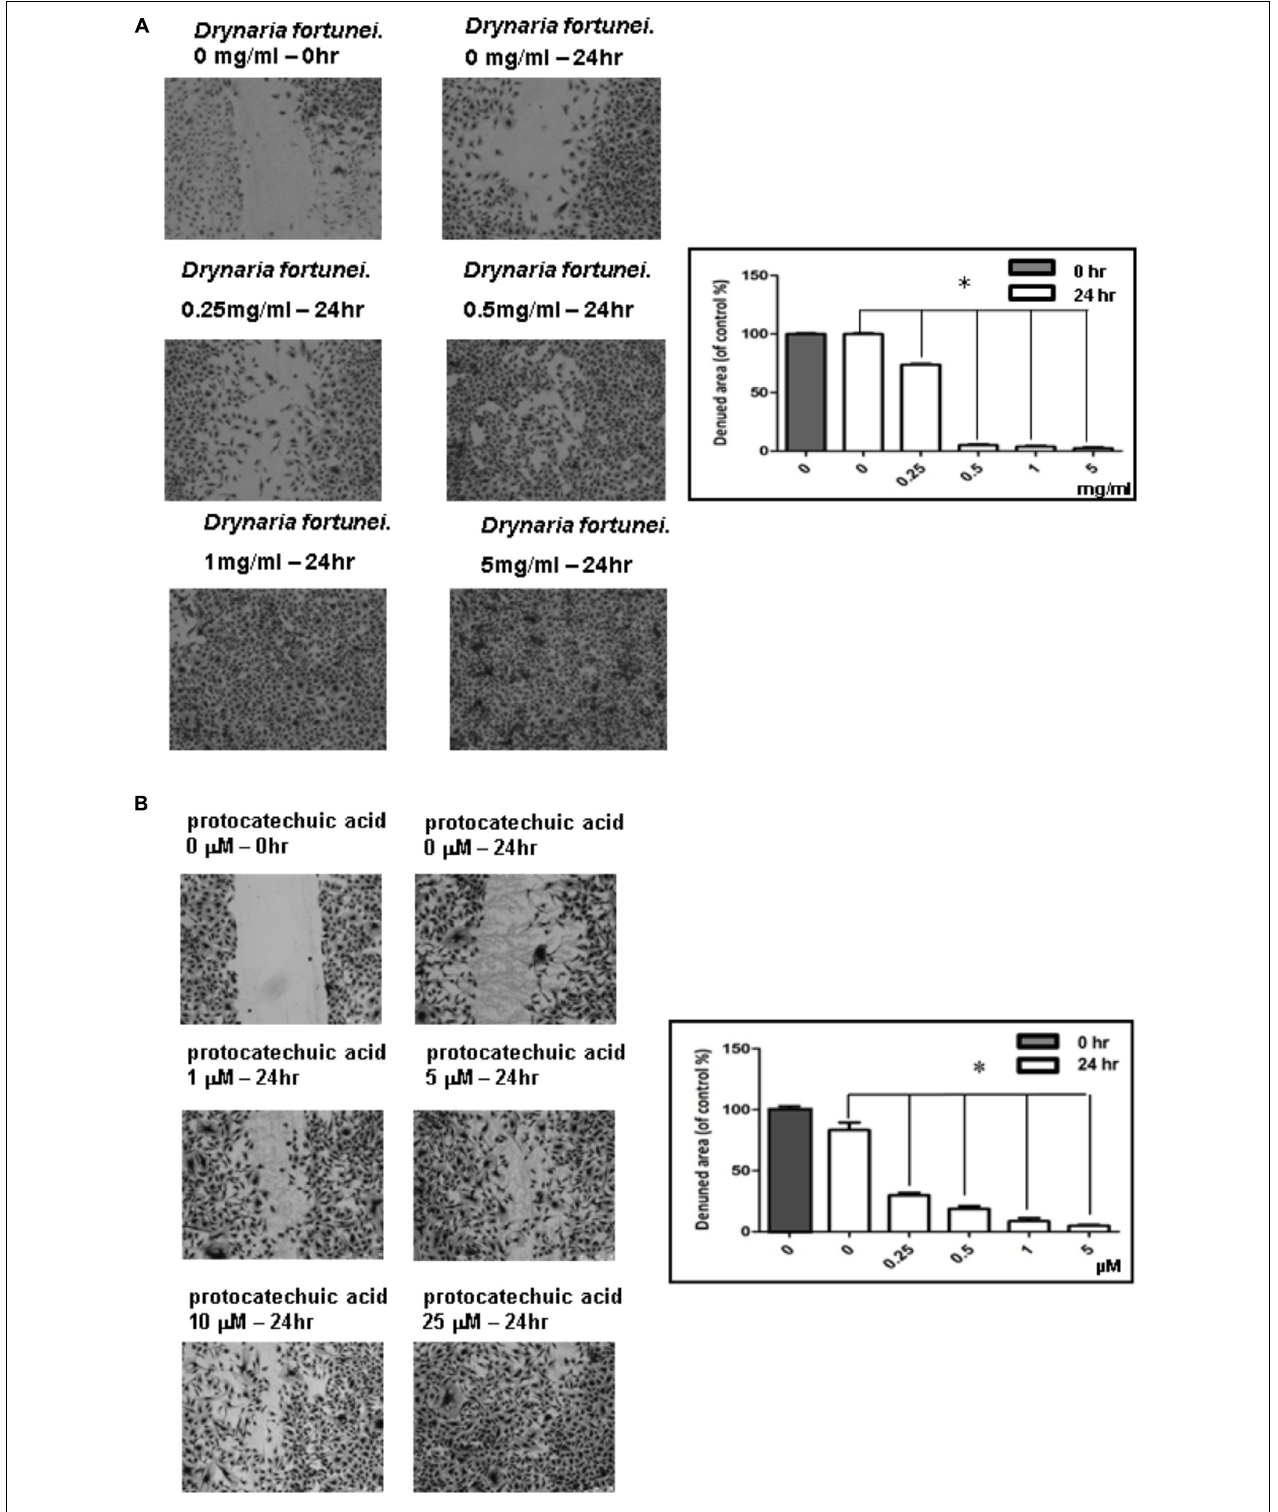
FIGURE 3 | The scratch wound healing effect of HUVECs with D. fortunei and PA treatment. The cells were incubated in EGM-2 medium with different concentrations of D. fortunei and PA as indicated for 24 h. The vertical wound was created using a 1 mL pipette tip. (A) The wound healing effect was enhanced up to complete recovery with increasing concentrations of 5 mg/ml D. fortunei . (B) PA also promoted the wound healing dose-dependently. Data were mean ± SD calculated from three individual experiments. An asterisk demonstrated the significant difference ( ∗ P < 0.05) compared with control.